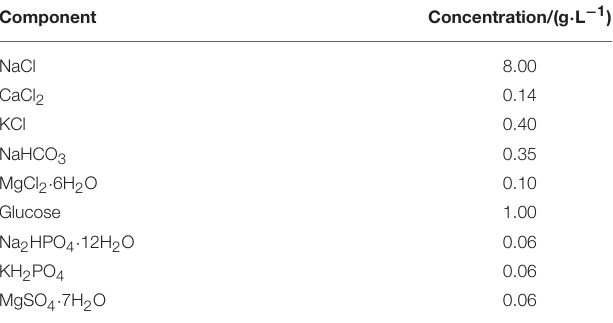
TABLE 1 | Composition of SBF solution.